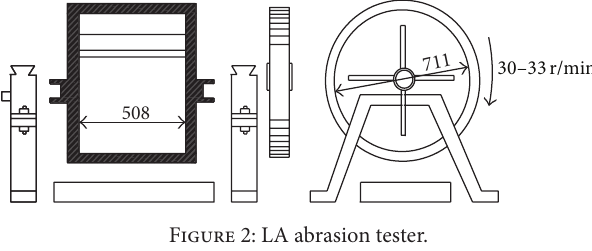
Figure 2: LA abrasion tester.